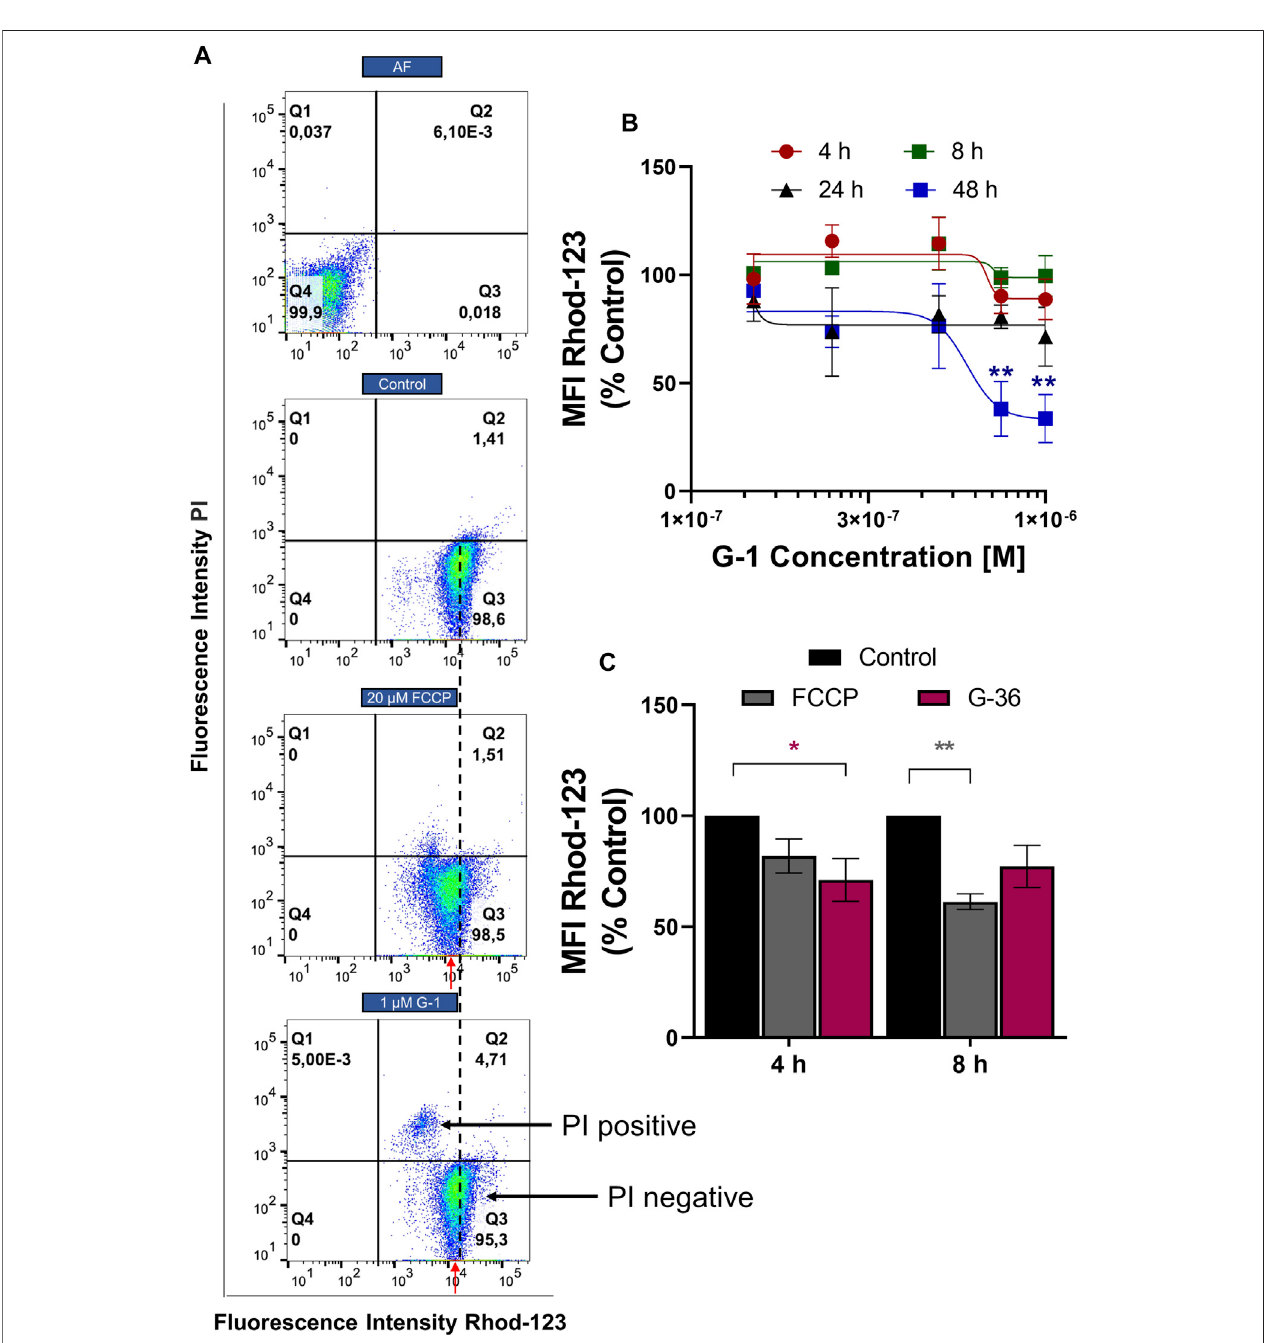
FIGURE 5 | ΔΨ m monitoring in Jurkat cells treated with G-1 or G-36. Jurkat cells were treated as indicated for different time intervals, stained with Rhod-123 and PI, and analyzed by fl ow cytometry. (A) Representative dot plots obtained by fl ow cytometry at 12 h of incubation. FCCP was used as a positive control. The MFI value (Rhod-123)forcontrolpopulationisdrawnbyablackdottedline.MFIvalues(Rhod123)fortreatedpopulationsareindicatedbyredarrowstodemonstratetheshifttothe leftfromthecontrolvalue. (B) MFImeanvalues(Rhod-123)forPI-negativepopulations(Q3asindicatedinA)arenormalizedtocontrolandgraphedasafunctionof G-1 concentrations. Data are mean ± SEM; N ≥ 3. For each time, comparison of control vs. treated samples was performed by one-way ANOVA with Dunnett post hoc testing, ** p < 0.01. (C) Bar charts showing the change in ΔΨ m induced by G-36 (10 μ M) and FCCP (20 μ M). Data are mean ± SEM; N ≥ 3. Two-way ANOVA and a post hoc Sidak analysis were performed to compare MFI values (G-36 or FCCP) with corresponding control. * p < 0.05, ** p < 0.01.